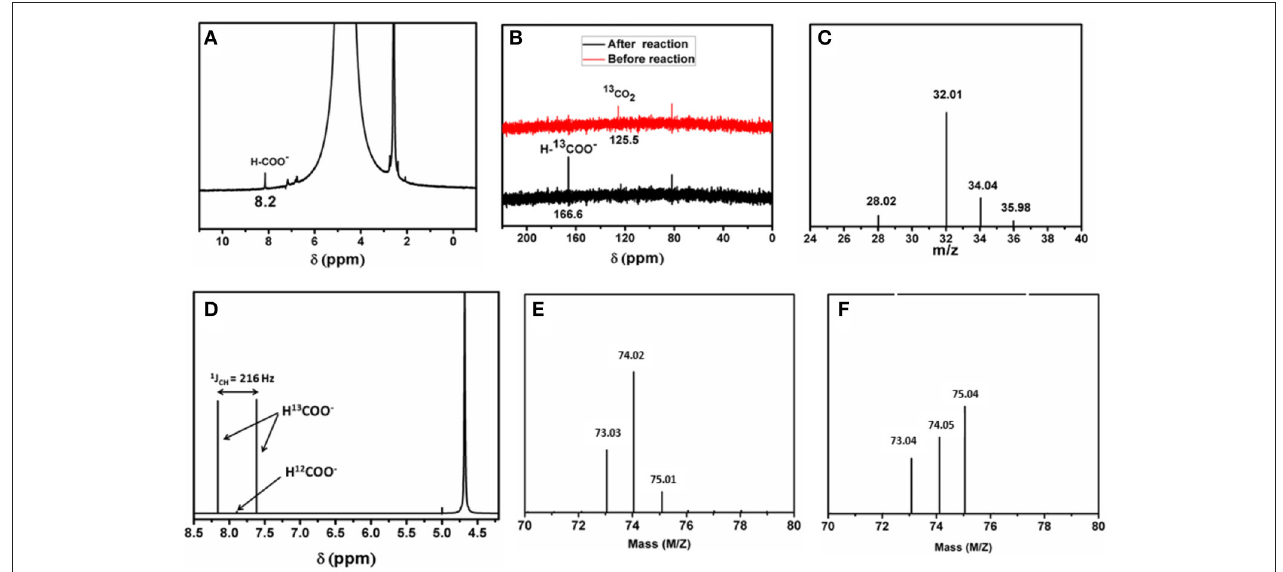
FIGURE 2 | (A) Representative 1 H-NMR of the product from photochemical CO 2 reduction. (B) 13 C-NMR spectrum of the reaction mixture before (red) and after (black) the reaction. (C) Full mass spectrum representing all the isotopes of the gaseous products (O 2, 16 O 18 O, 18 O 18 O and N 2 ). (D) 1 H-NMR spectrum of the reaction mixture using 13 CO 2 . (E) Mass of ethylformate (molecular peak) after reaction with H 2 O and (F) with D 2 Oand H 2 O mixture.